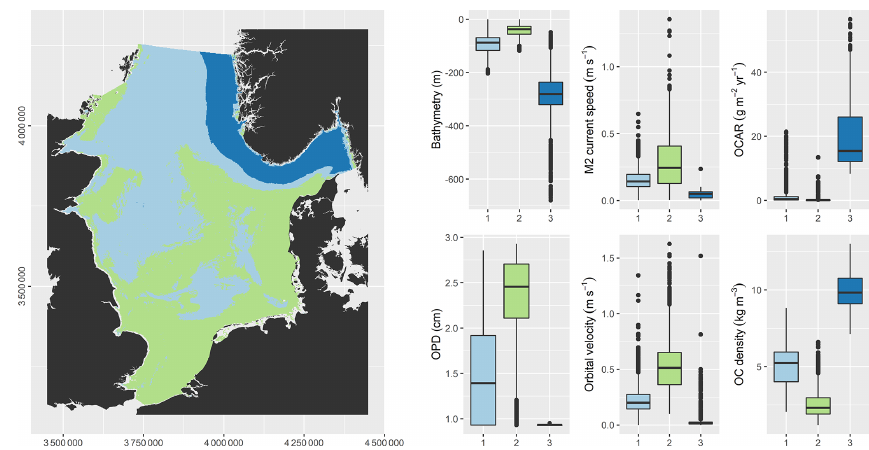
Figure 7. Regionalisation of the North Sea and Skagerrak: region 1 (light blue) – transition zone; region 2 (green) – turnover zone; and region 3 (dark blue) – burial zone. Note that boxplots are based on 10000 randomly placed points rather than all pixels.